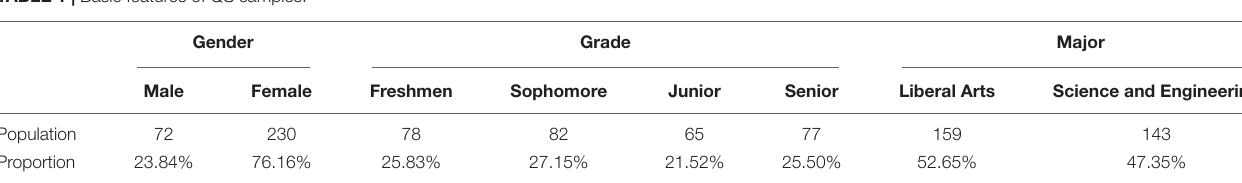
TABLE 1 | Basic features of QS samples.